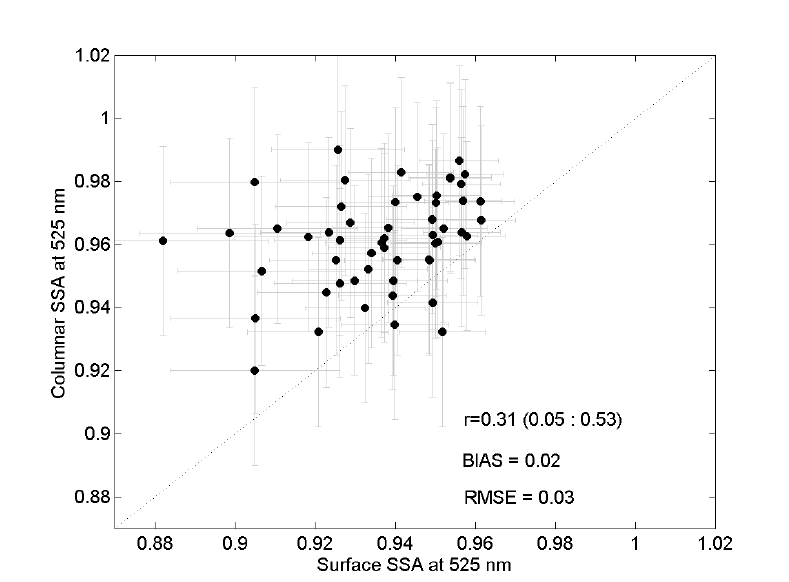
Figure 9. Comparison of columnar (Level 2.0 AERONET) and surface single scattering albedo (SSA) (aethalometer + nephelometer) at 525 nm. Grey error bars show uncertainties. Dashed line (x = y) only for a reference.